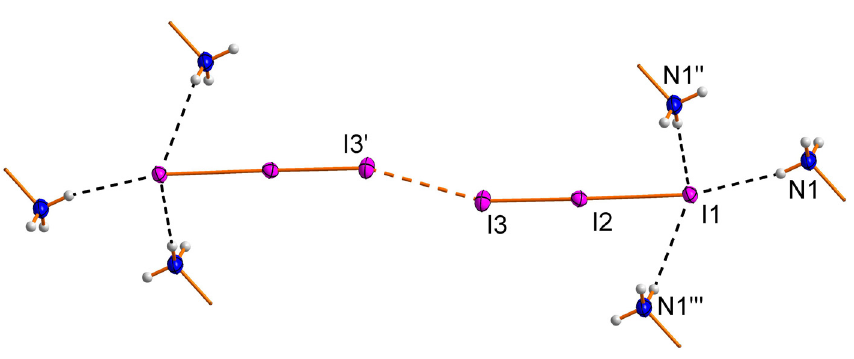
Figure 1. The I 62 − hydrogen bonded anion in the structure of 18dbt. (Symmetry codes: ' = − 1 − x , 1 − y , − z ; ’’ = 1 − x , 1 − y , 1 − z ; ’’’ = − 1 + x , y , z ; displacement ellipsoids are drawn at the 70% probability level).